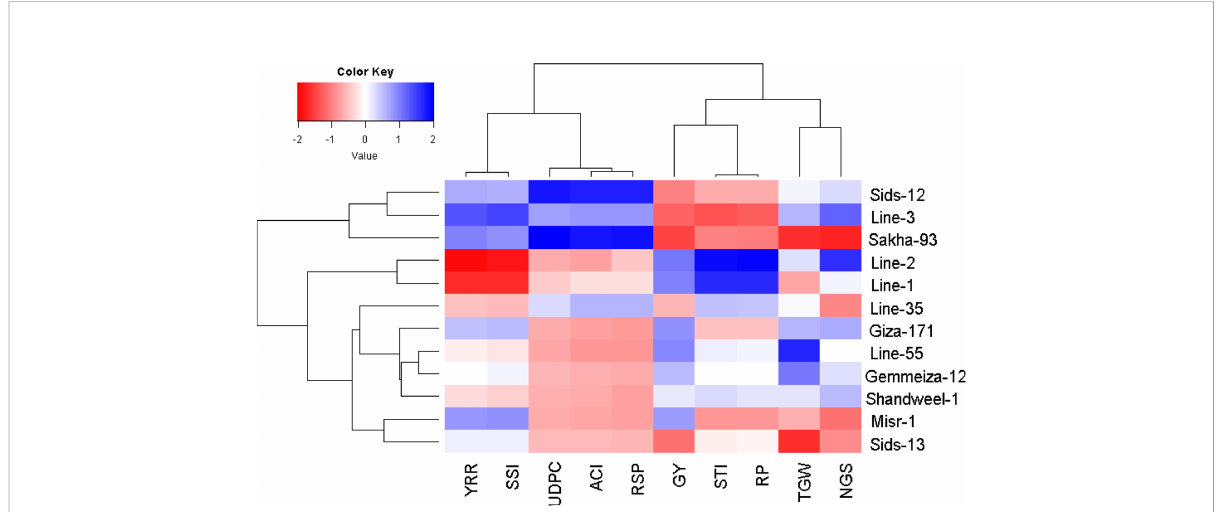
FIGURE 5 Heatmap and hierarchical clustering divide the evaluated twelve bread wheat genotypes into different clusters based on yellow rust resistance measurements, heat tolerance indices, and agronomic performance. Red and blue colors imply low and high values for the corresponding parameters, respectively. RSP, rust severity percentage, ACI, the average coef fi cient of infection, AUDPC, area under disease progress curve, YRR, yield reduction ratio, SSI, stress sensitivity index, STI, stress tolerance index, RP, relative performance, NGS, number of grains per spike, TGW, 1000-grain weight, and GY, grain yield.